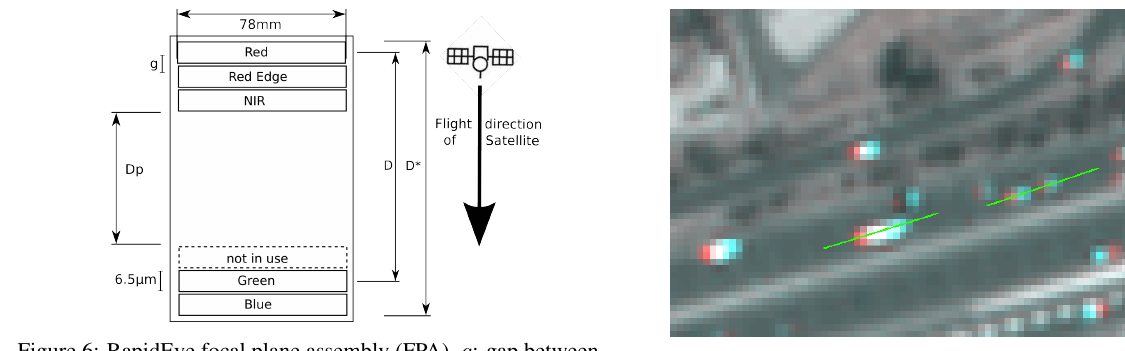
Figure 9: Example of a combined PAN (red) and multispectral (cyan) Pl´eiades image, section 160 × 100 m of the M1 in Mel- bourne near the harbour.